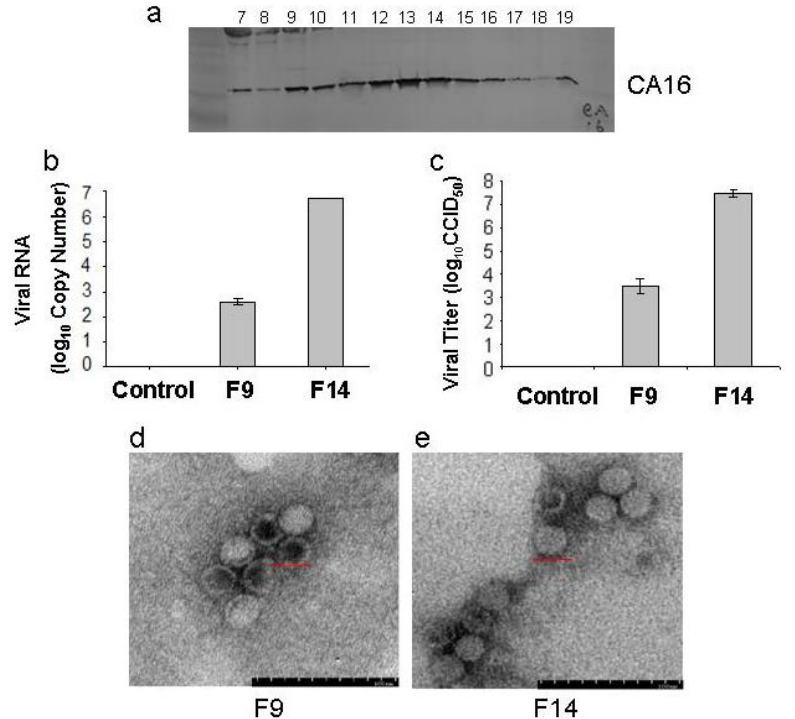
Figure 3. Biological characteristics of CC024 vaccine strain. ( a ) Concentrated virus was layered onto 20%–60% sucrose gradients and subjected to ultracentrifugation as described in Materials and Methods. Nineteen fractions were taken from the top to bottom and assayed. The odd fractions were analyzed by Western blot using a CA16 polyclonal antibody; ( b ) Viral RNAs of peaks at F9 and F14 were detected by RT-PCR; ( c ) Viral titers of peaks at F9 and F14 were detected in Vero cell lines; ( d , e ) Electron microscopy of CC024 virus from peaks at F9 and F14. Bar = 200 nm.